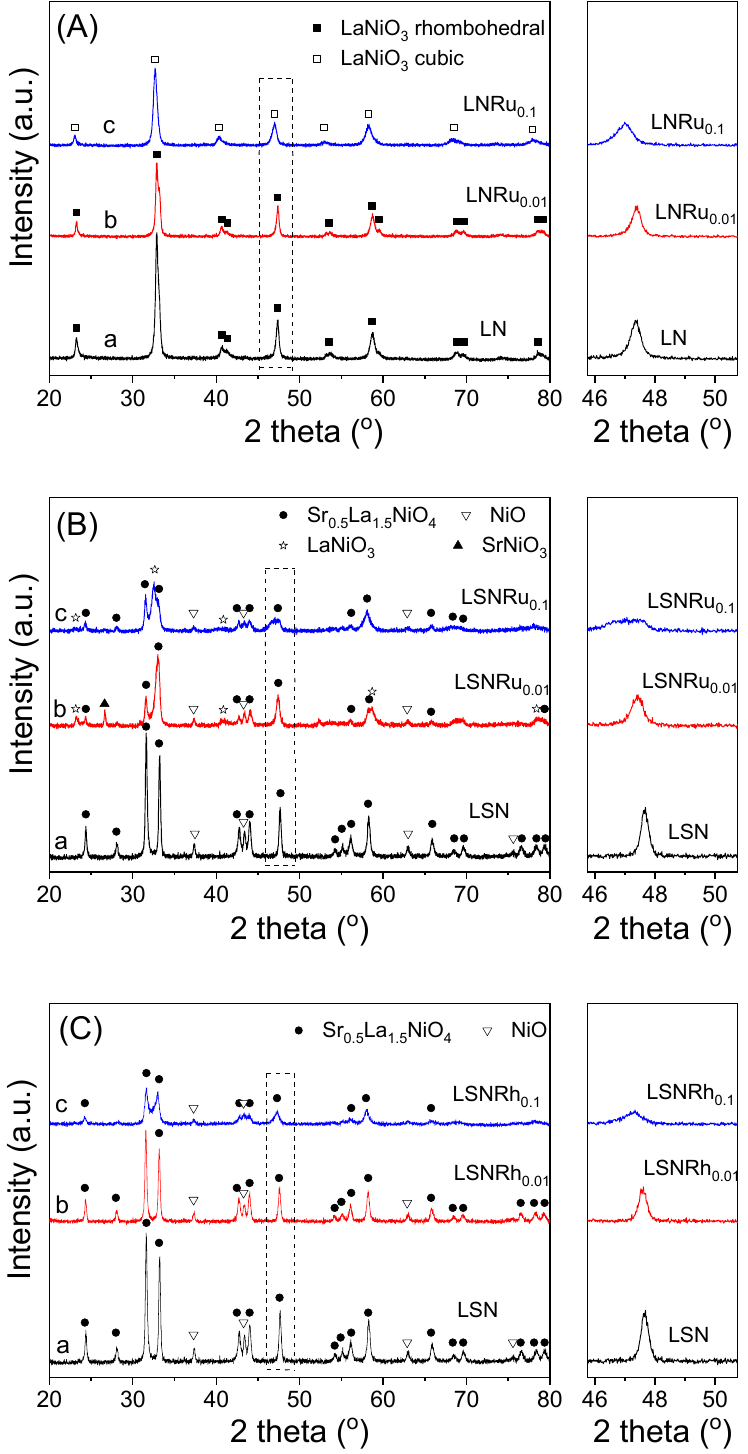
Figure 1. X-ray diffraction patterns of the as-prepared perovskite samples: ( A ) LNRu x , ( B ) LSNRu x , and ( C ) LSNRh x . In the magnified pattern on the right of each graph is shown the peak attributed to the (200) reflection.